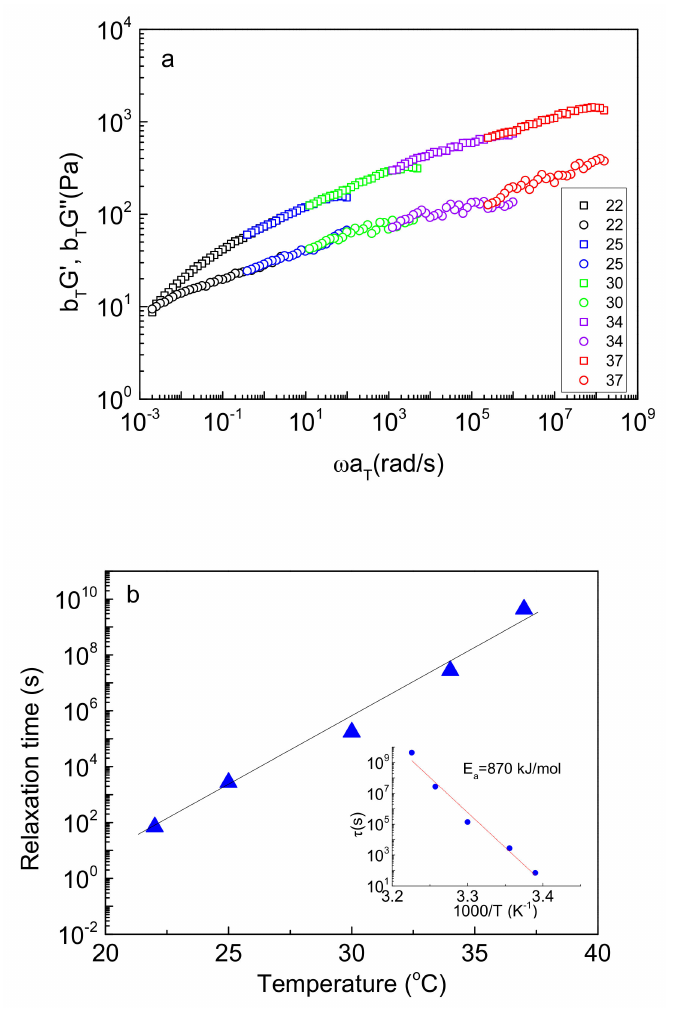
Figure 6. ( a ) Time–temperature superposition master curve of G’ (squares) and G” (circles) at the reference temperature of 22 ◦ C and ( b ) temperature dependence of relaxation time, τ and the corre- sponding Arrhenius plot (inset) for the NaALG- g -P(NIPAM 80 - co -NtBAM 20 ) graft copolymer/water system ( C p = 5 wt %). The solid lines are linear fits of the